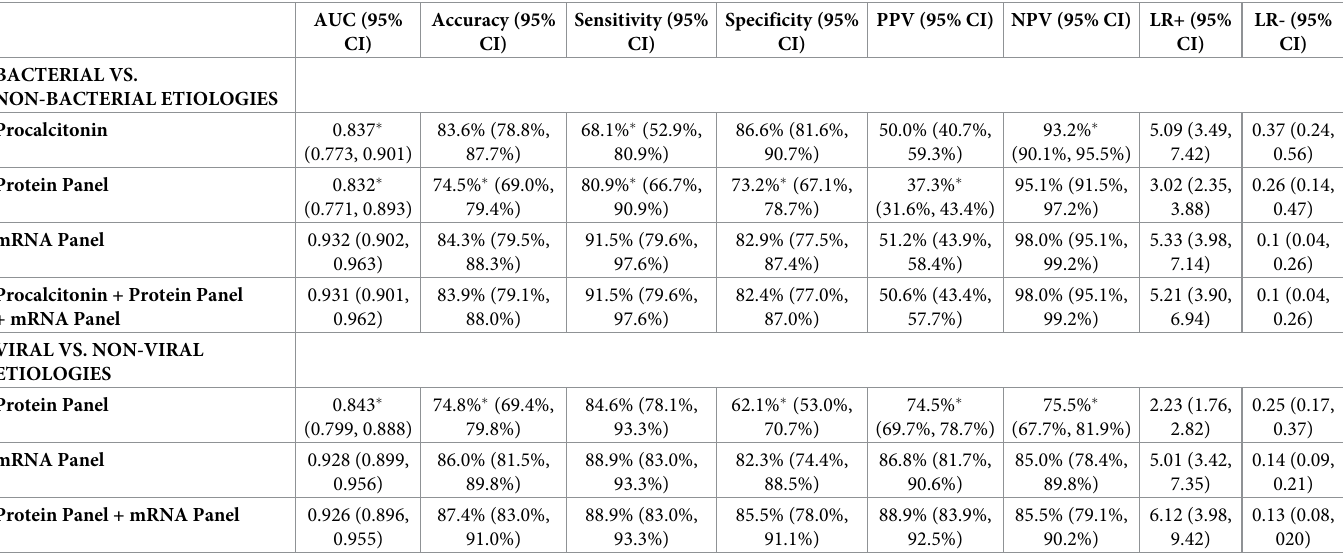
Table 3. Test performance for bacterial vs. non-bacterial etiologies and viral vs. non-viral